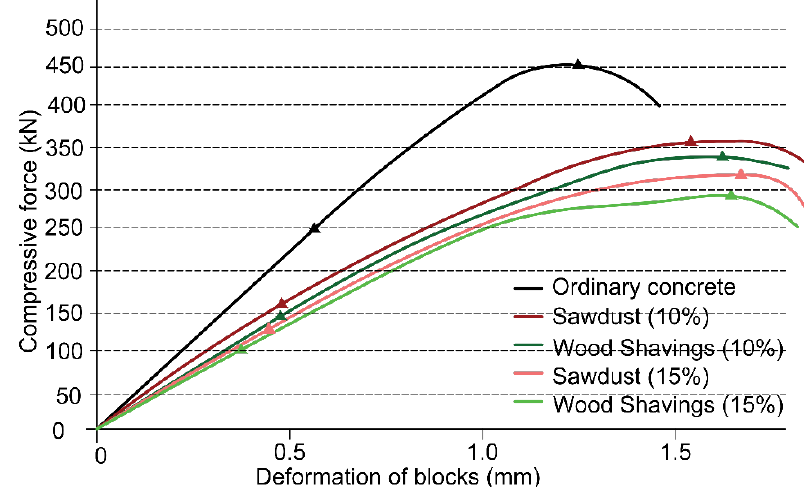
Figure 5. Capacity Curves (Compressive Force — Deformation) of the Concrete Blocks Suitable for Structural Use.